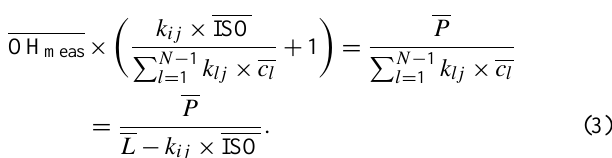
Figure 1. The relation between mixing ratios of isoprene and OH (25 July 2003, 09:00–15:00CET). The detection limit ( S/N = 2) of the LIF instrument is 0.1ppt for OH and of the PTR-MS 41ppt for isoprene at a measuring frequency up to 0.2Hz (Dlugi et al., 2010). The results for three time average intervals are given with the green dots for OH mod